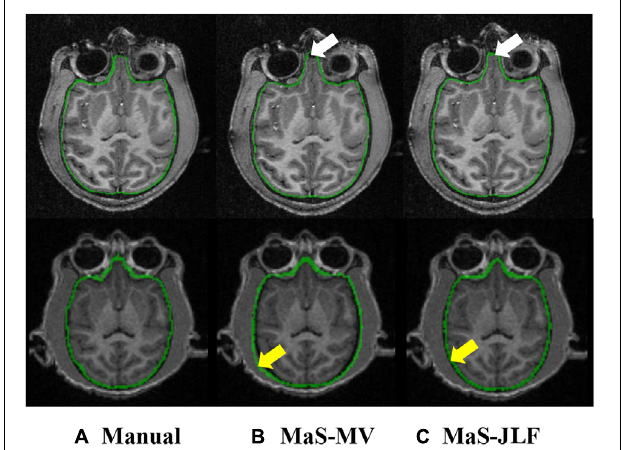
FIGURE 2 | Example T1 images from D24 (top) and D30 (bottom) , overlaid with manual segmentation, MaS-MV, and MaS-JLF from left to right. Arrows indicate differences in segmentations. MaS, multi-atlas segmentation; MV, majority voting; JLF, joint label